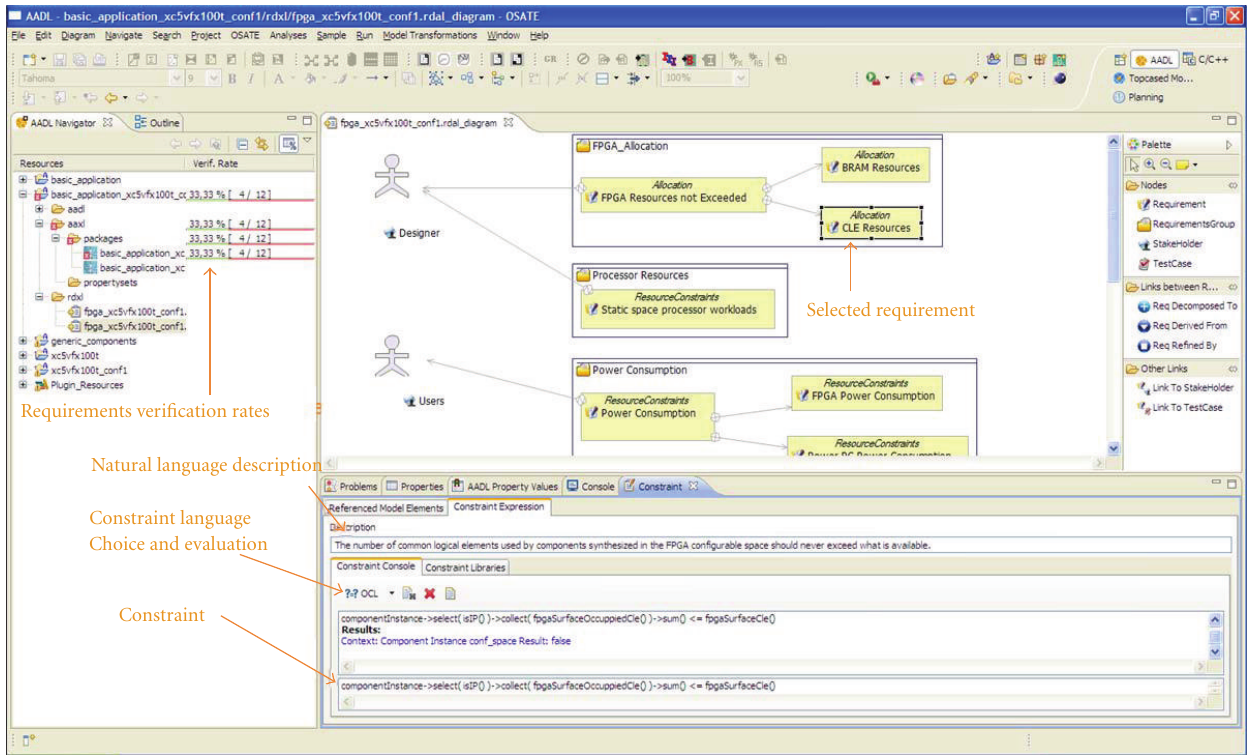
Figure 11: A requirements specification created for Conf 1 of the FPGA with